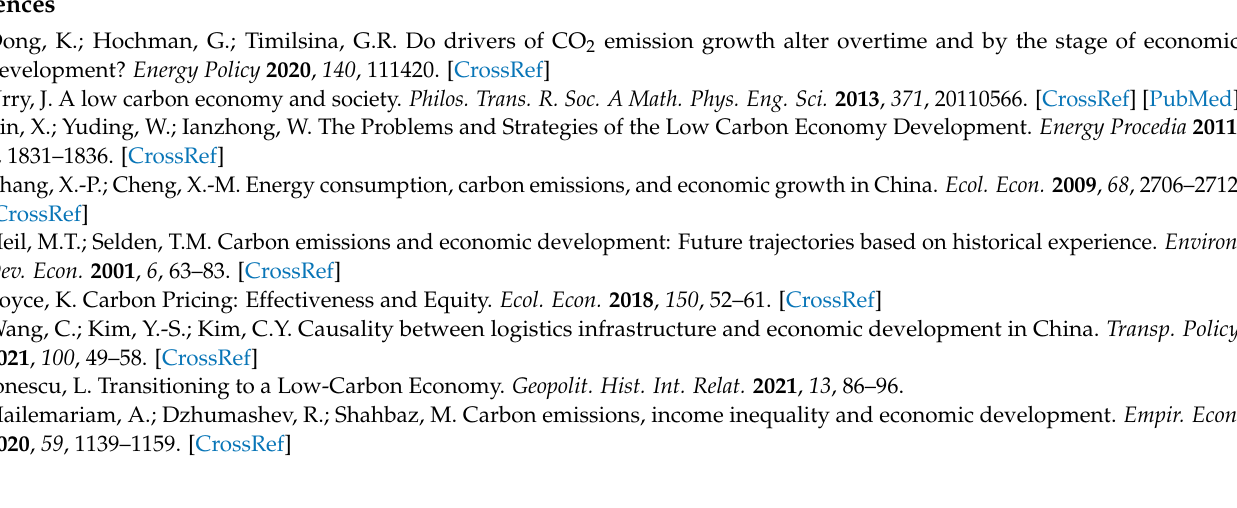
Figure A2. Conceptual diagram of freight location distribution.